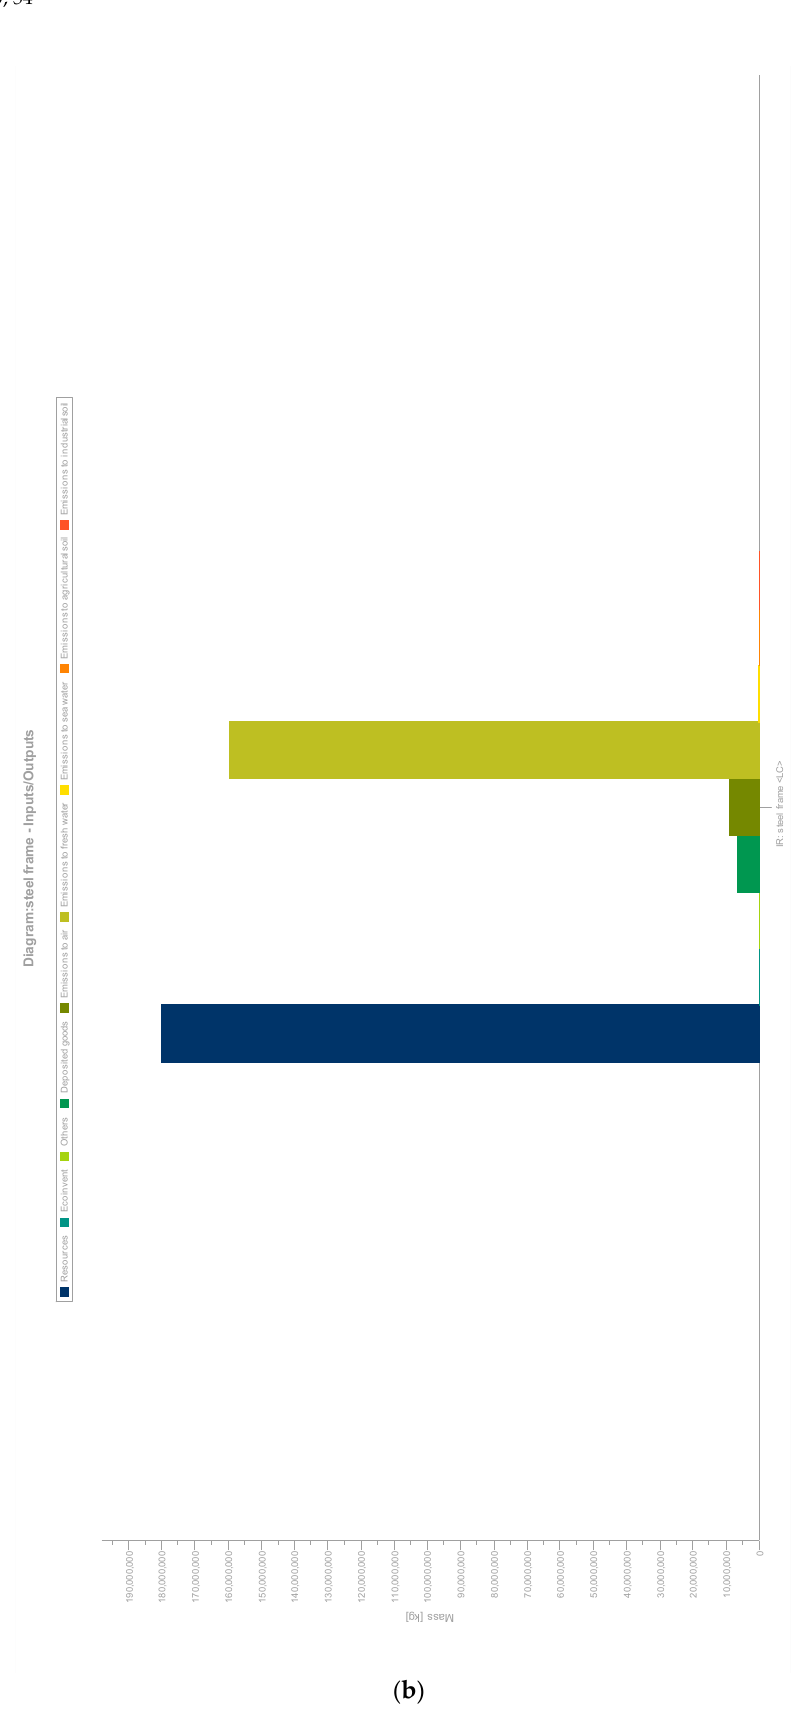
Figure 8. Total pollution in di ff erent categories: ( a ) concrete building; ( b ) steel